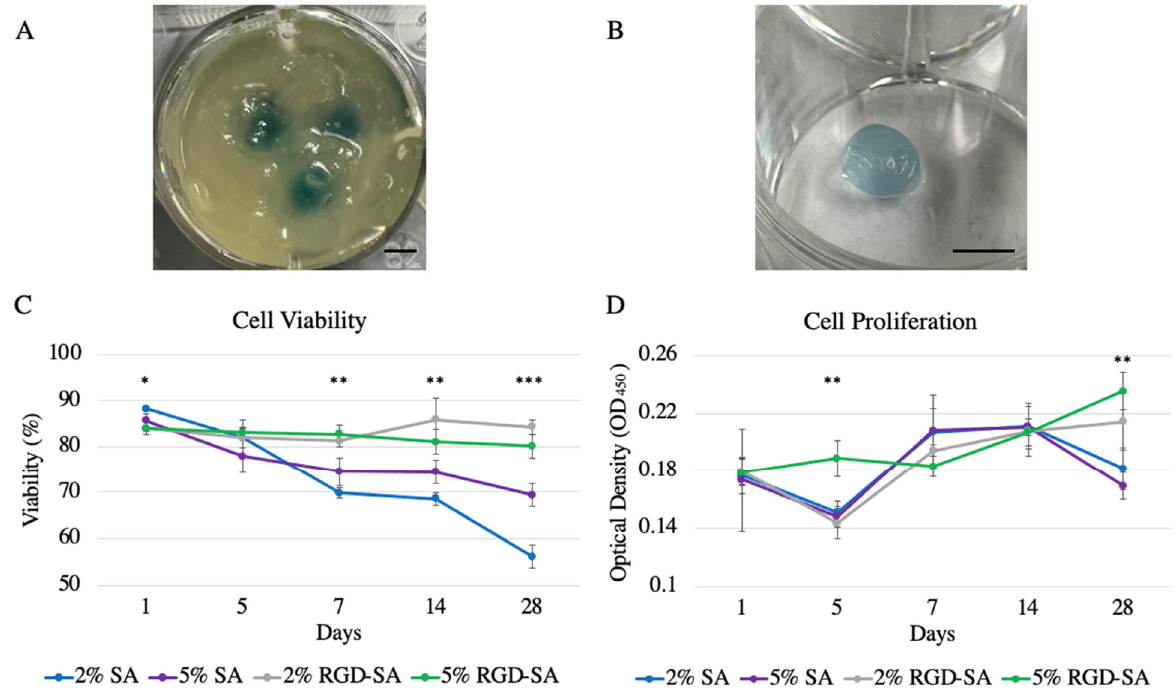
Figure 4. Adult human dermal fibroblast cell viability and proliferation after 3D bioprinting in different alginate bio-inks over 28 days. ( A ) 6 mm cylinders were 3D printed with adult human dermal fibroblast-laden alginates in freeform reversible embedding of suspended hydrogels (FRESH). Scale bar = 5 mm. ( B ) After FRESH removal and cross-linking, the 3D printed cylinder was successfully harvested for further cell viability and proliferation testing. Scale bar = 5 mm. ( C ) Cell viability in 2% ( w / v ) sodium alginate (SA) demonstrated the lowest cell viability compared to RGD-modified SA (RGD-SA) after 7 days. Cell viability in 2% SA continued to decrease over time. Cells printed in RGD-SA remained viable over time. ( D ) Cells after 3D bioprinting in different alginates demonstrated varied proliferation. 5% RGD-SA demonstrated the highest cell proliferation compared to 2% RGD-SA at day 5 and compared to SA at day 28. Cells were able to successfully proliferate in RGD-SA with 5% RGD-SA supported better cell proliferation compared to 2% RGD-SA. * denotes p < 0.05; ** denotes p < 0.01; *** denotes p < 0.001. Error bars represent standard error.